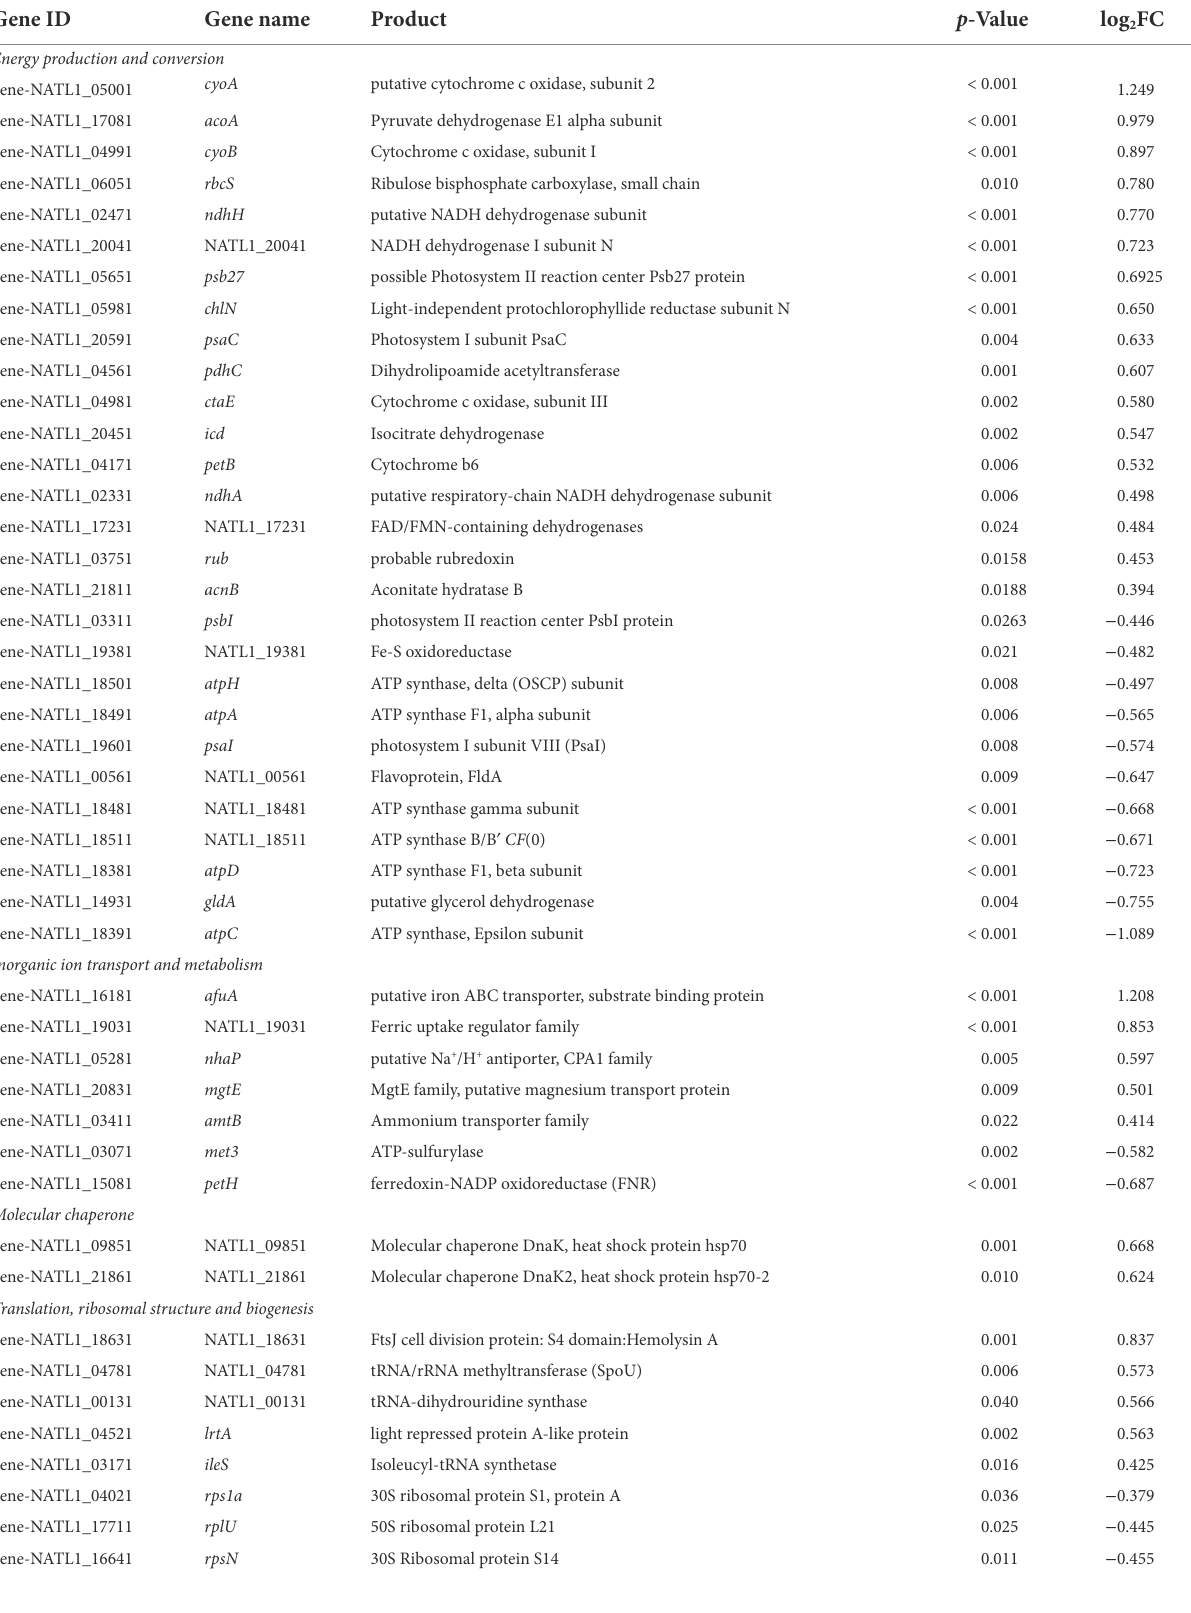
TABLE 2 List of a part of differentially expressed genes ( p < 0.05) in low salinity acclimated Prochlorococcus NATL1A. Gene ID Gene name